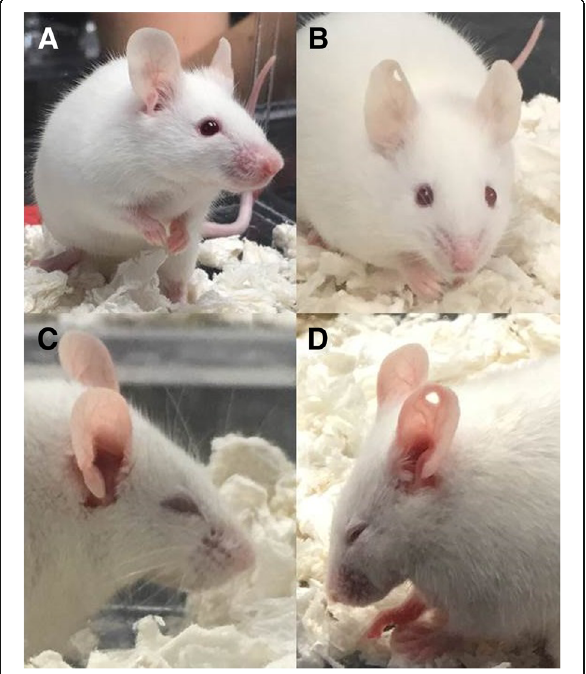
Fig. 1 Representative pictures of spontaneous grimace induced in free-moving CD1 mice after peripheral CGRP. a Facial features observed at baseline, ( b ) facial features observed 30 min after peripheral administration of saline (PBS), ( c and d ) facial features observed 30 min after peripheral administration of CGRP (0.1 mg/kg,